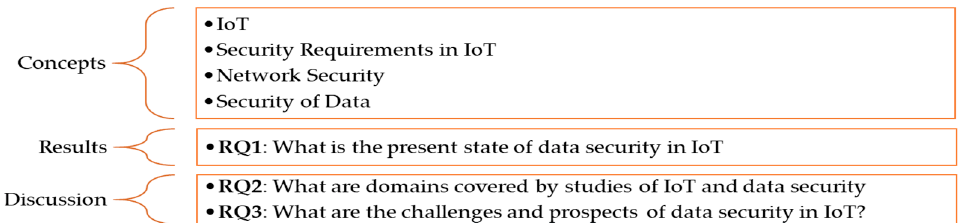
Figure 1. The study’s objectives.